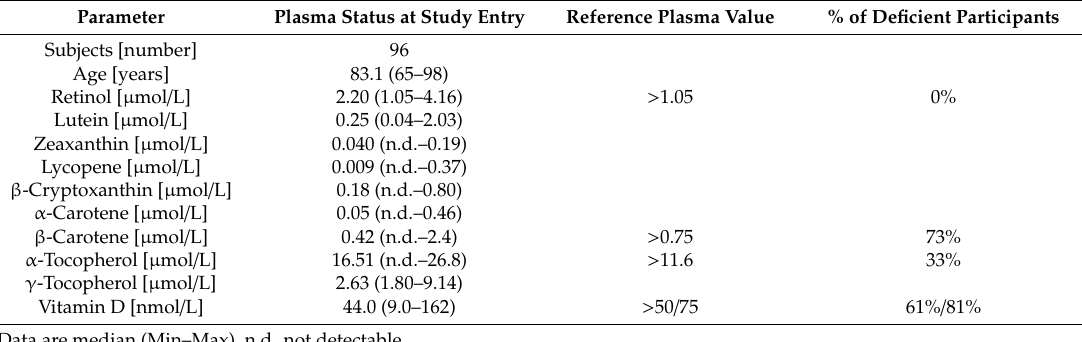
Table 1. Status of fat soluble micronutrients of institutionalized elderly at study entry compared to reference values